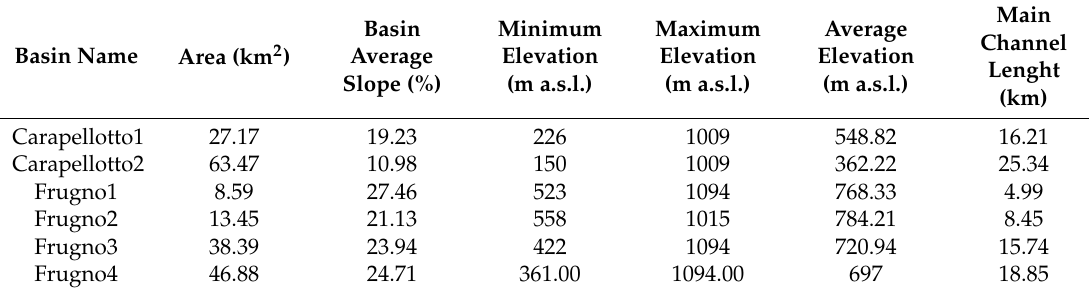
Table A2. Sub-basins candidate to be gauged and main morphologic